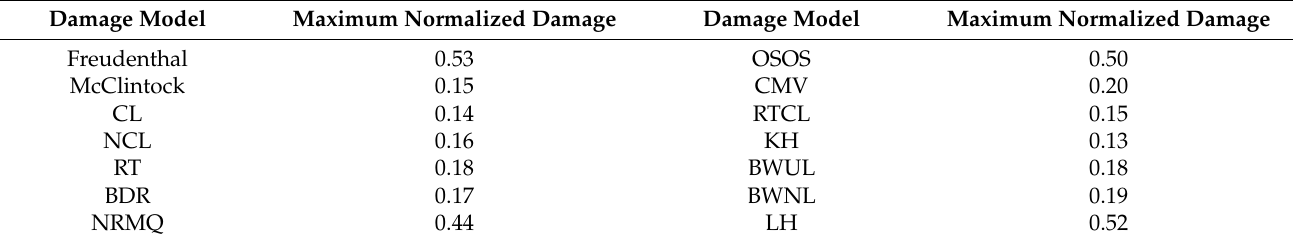
Table 2. Comparison of predicted maximum normalized damage